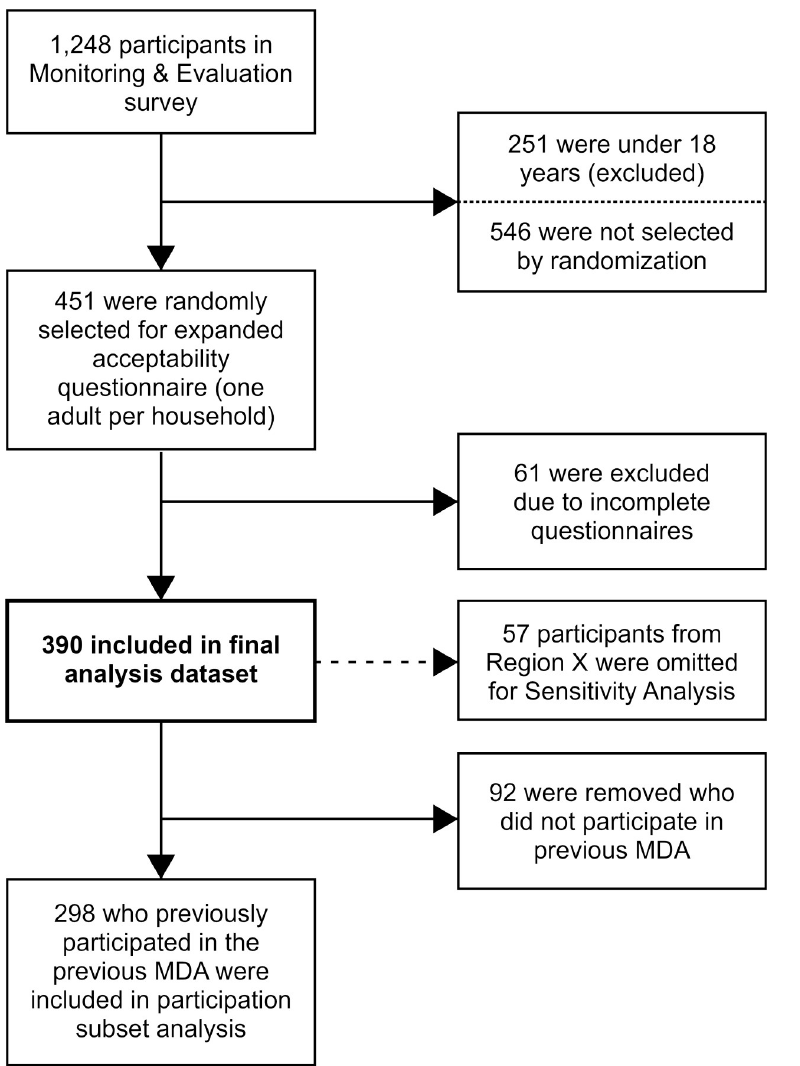
Fig 2. Acceptability study sampling frame and subset